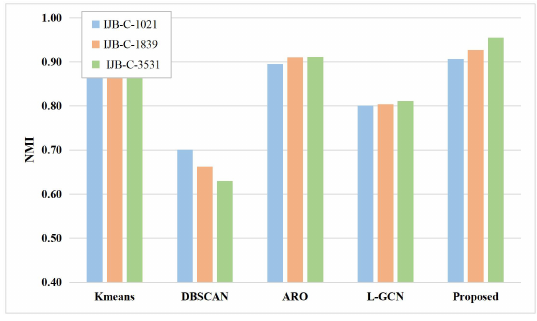
Figure 7. Performance comparison on the IJB-C dataset. Table 5. Method comparison on the three subsets of IJB-B.